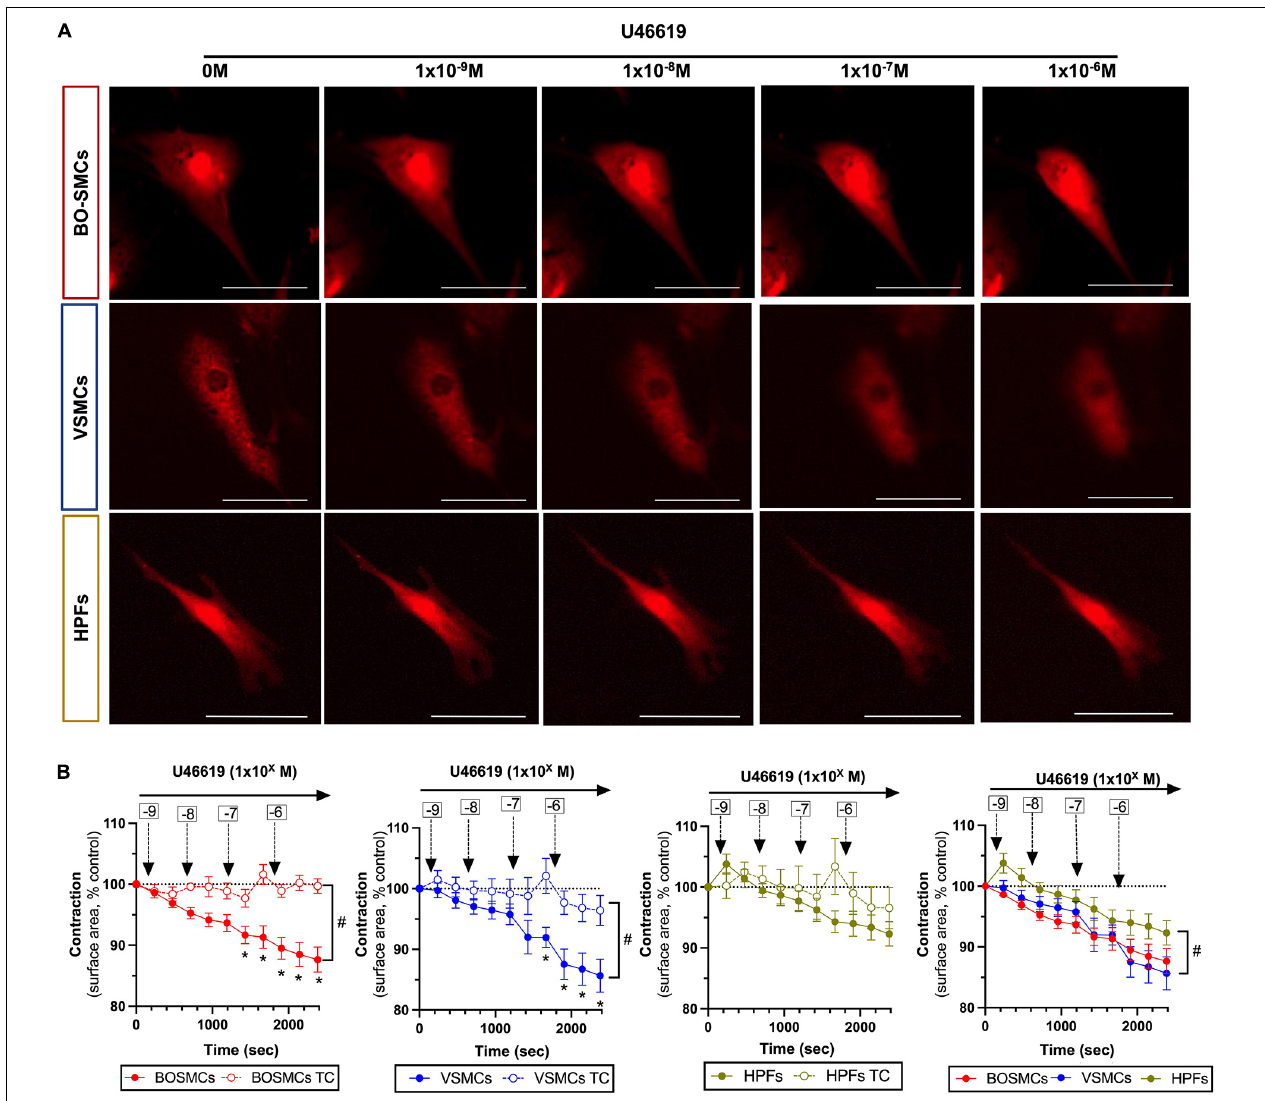
FIGURE 2 | Contraction responses to U46619 of blood outgrowth smooth muscle cells (BO-SMCs), vascular smooth muscle cells (VSMCs), and fibroblasts (HPFs). Representative images of contracting cells captured at 10 min after addition of cumulative concentrations of U46619 (1 × 10 − 9 to 10 − 6 M) (A) and pooled data (B) . Data in (B) are mean ± SEM; for BO-SMCs, n = 23 using cells from four separate donors; for VSMCs, n = 14 using cells from three separate donors; and for HPFs, n = 9 fields using cells from three separate donors. Filled symbols represent treated cells and open symbols represent untreated “time-control” (TC) cells. Statistical differences were tested using two-way ANOVA with a Sidak-multiple comparison post hoc test comparing individual U46619 concentration responses with cell-relevant time controls (* p < 0.05) or two-way ANOVA comparing the absence vs. presence of U46619 over time ( # p < 0.05). Data in panel 4 (bottom right hand graph) which include all cell types were tested using a two-way ANOVA ( # p < 0.05) comparing VSMCs or HPFs with BO-SMCs. Scale bars represent 100 µ